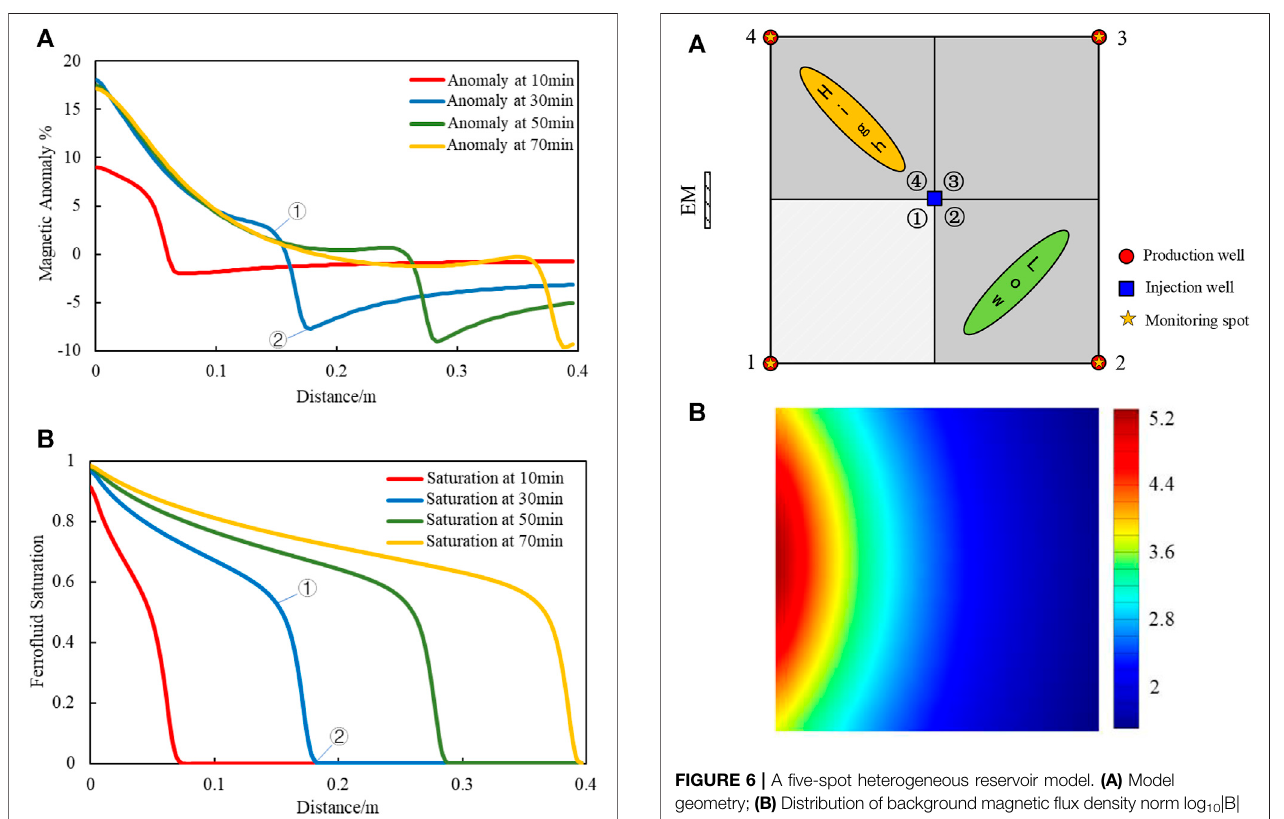
FIGURE5| Theferro fl uidsaturationandmagneticanomalycurvesalong the porous media at 10, 30, 50,70 min. (A) Magnetic anomaly curves; (B) Saturation curves.